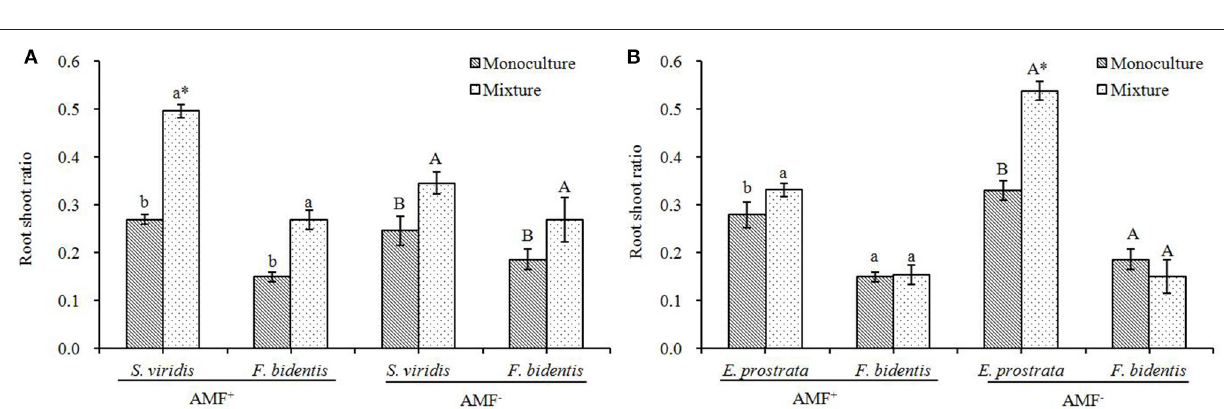
FIGURE 5 | Effects of R. intraradices on the root to shoot ratio of exotic plant F. bidentis and two native plants S. viridis (A) and E. prostrata (B) when grown in monoculture or in mixture. Different lower case letters indicate significant difference between monoculture and mixture treatments with inoculation of R. intraradices at P < 0.05. Different capital letters indicate significant difference between monoculture and mixture treatments without inoculation of R. intraradices at P < 0.05. *indicate significant difference between inoculation and non-inoculation treatments at P < 0.05. Error bars represent ± SE of mean ( n =